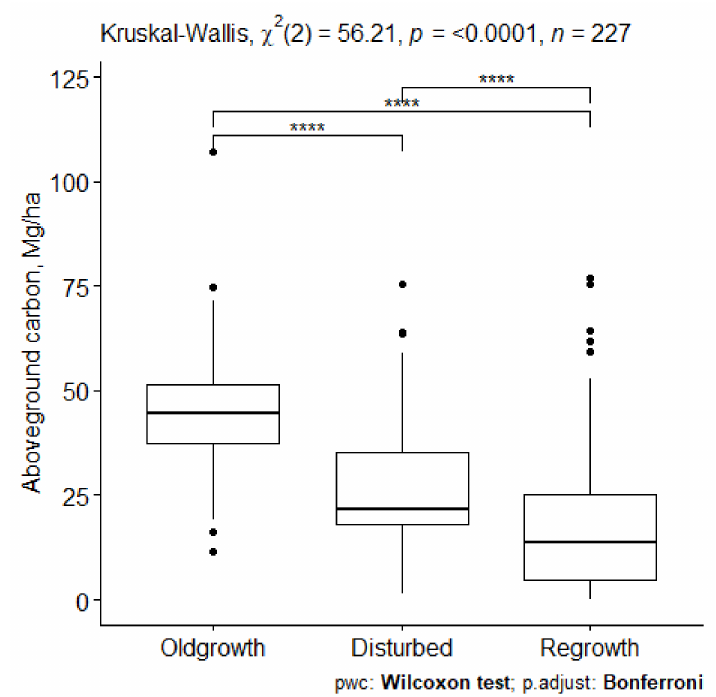
Figure 2. Aboveground carbon stocks in old-growth, disturbed and re-growth woodlands. Statis-tical significances are indicated: p -value < 0.001 ‘***’. Source: Graph by the authors.